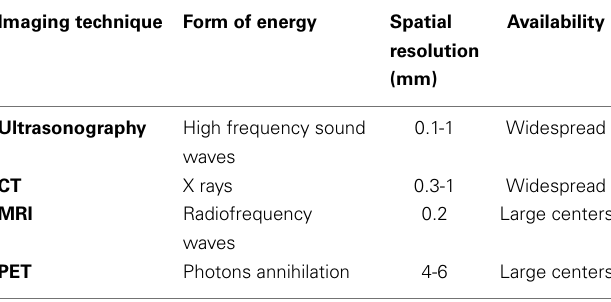
Table 1 | Features of main non-invasive imaging technique for vascular imaging